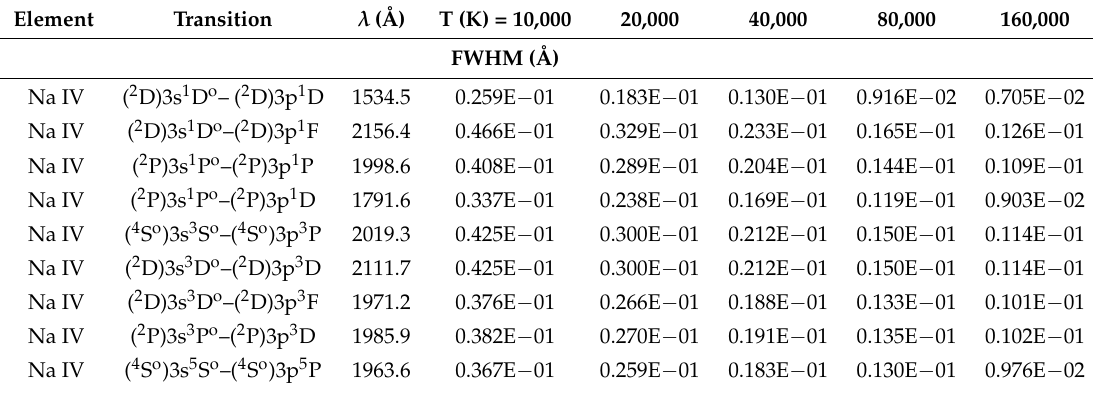
Table 1. FWHM (full width at half intensity maximum; Å) for Na IV spectral lines, for a perturber density of 10 17 cm − 3 and temperatures from 10,000 to 160,000 K. Calculated wavelength ( λ ) of the transitions (in Å) is also